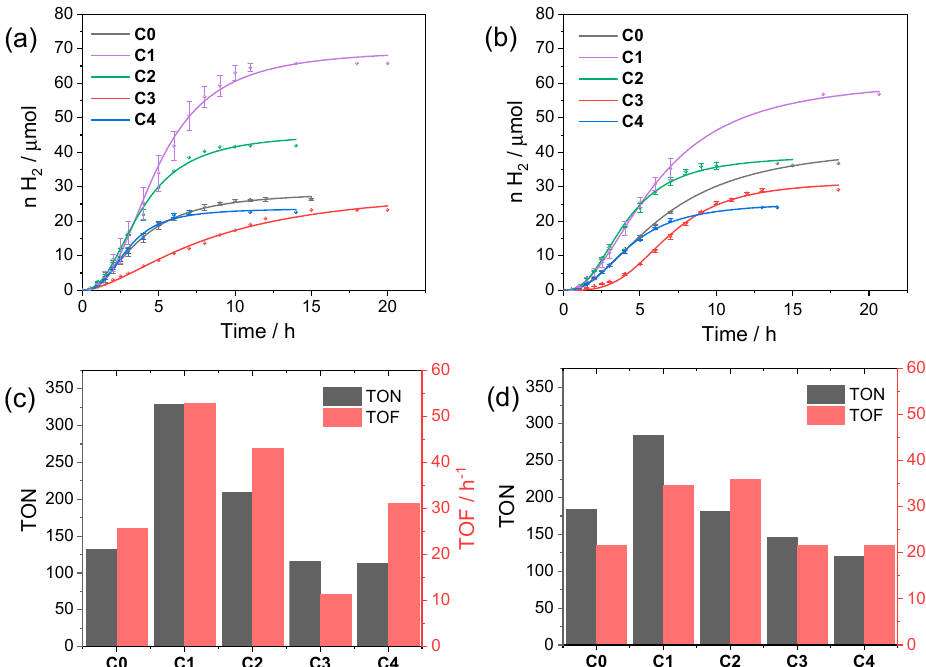
Figure 4. Kinetics of hydrogen evolution obtained upon visible light irradiation of aqueous solutions (5 mL) containing 0.11 mM CuInS 2 @ZnS QDs, 0.5 M ascorbate, and 40 µM C0–4 at ( a ) pH 4 and ( b ) pH 5; photocatalytic data in terms of maximum TONs after 24 h and TOFs at ( c ) pH 4 and ( d ) pH 5.